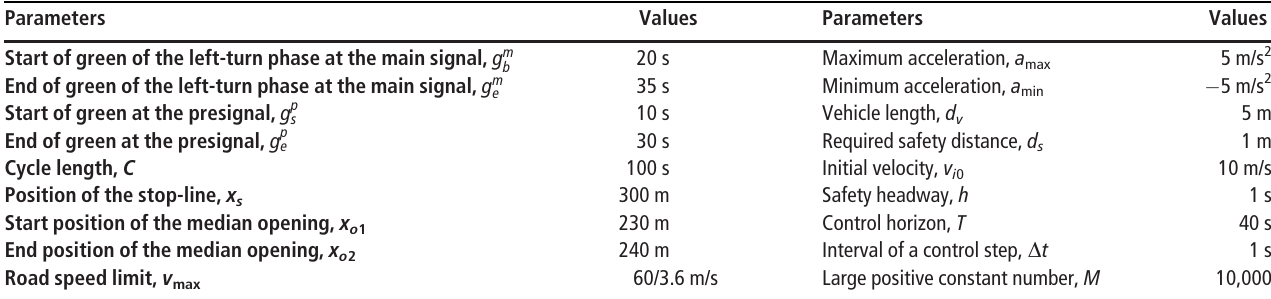
Table 1 Input parameters of the case study Parameters